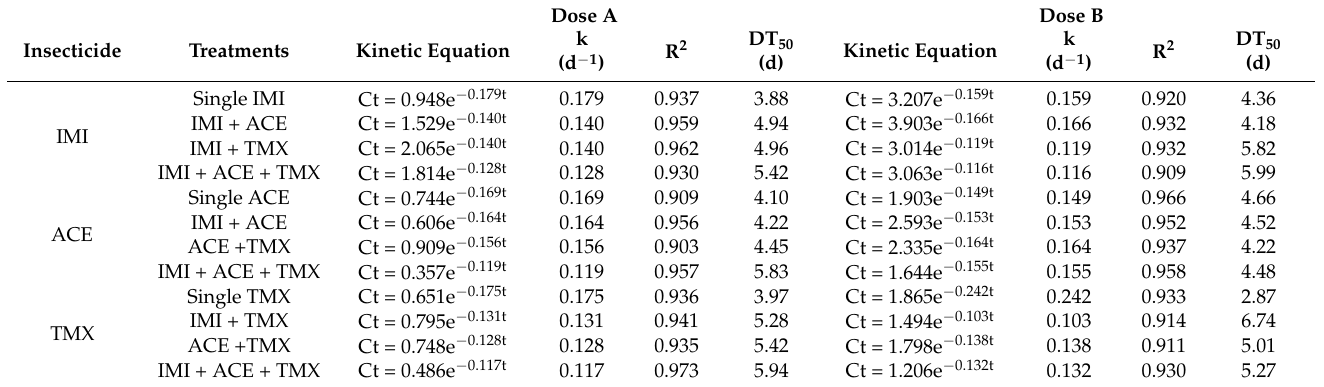
Table 1. First-order kinetic modeling for dissipation of three neonicotinoids in Brassica chinensis L. Dose A Dose B Insecticide Treatments Kinetic